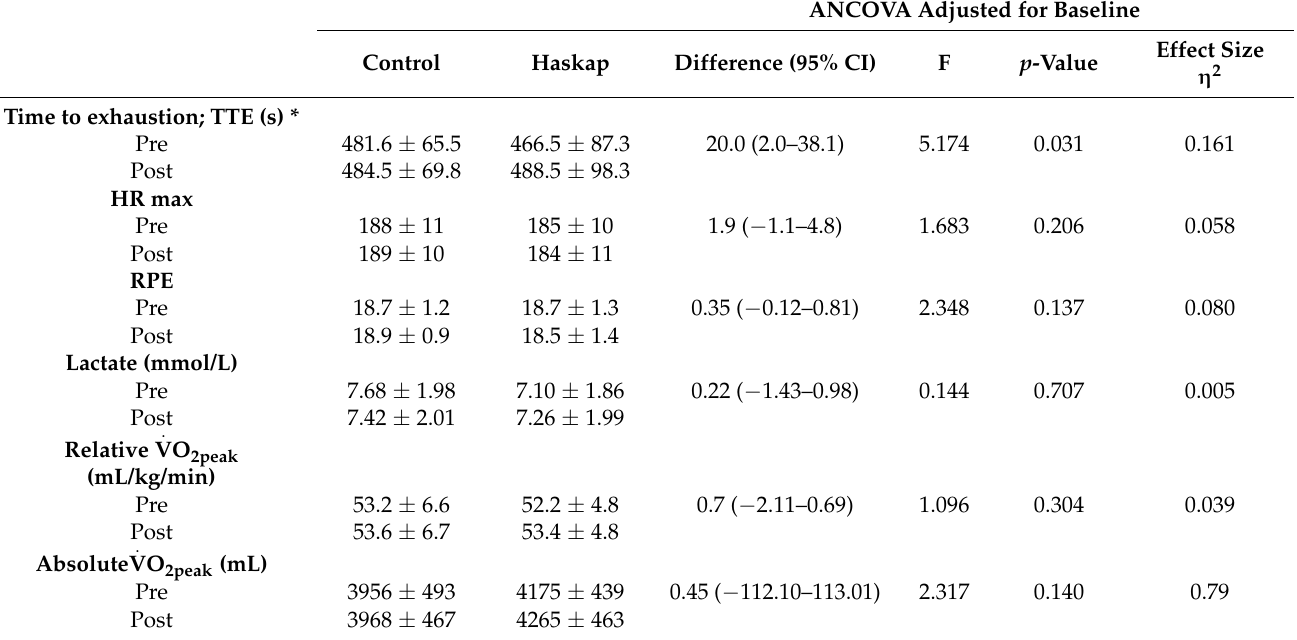
. Table 4. Data from the V O 2peak test before and after the intervention of